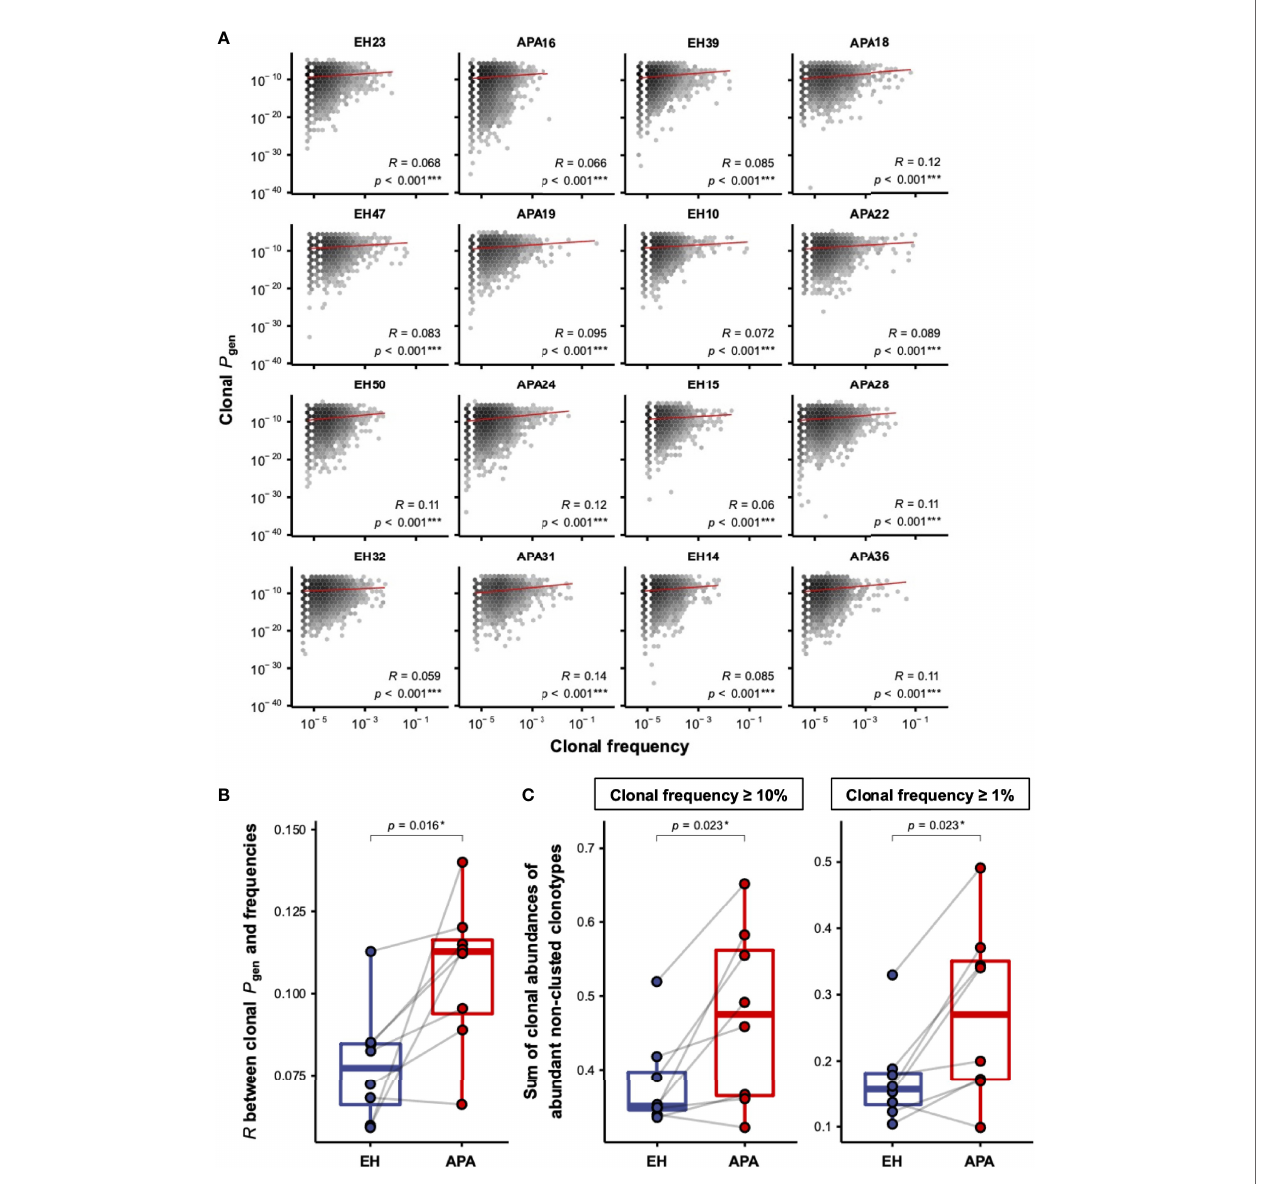
FIGURE 3 | Thecorrelationbetweenfrequencies and P gen ofTCR b clonotypes inAPAandEHpatients. (A) Thedistributionoffrequenciesand P gen ofTCR b clonotypeswas illustratedbythehexagonalheatmapforeachpatient. Thecolordepthrepresentedthenumber of TCR b clonotypes with the corresponding clonal frequency and P gen . Thecorrelationbetweenlog10-transformedfrequencies and P gen ofallclonotypeswascomputedusinglinear regressionanalysis.Thesolidredlinerepresentedthe fi ttedlinear regressionlinefor theobserveddata.Thecorrelationcoef fi cient ( R )and p -value ( p ) oftheassociationbetweenclonalfrequencies and P gen werelabeledfor eachpatient. Thetwo- sided p -values wereshownfrom thePearsoncorrelationtest. (B) Pearsoncorrelationcoef fi cients( R )betweenlog10-transformedfrequencies and P gen ofTCR b clonotypes were comparedbetweenAPAandage-matchedEHpatients. Thesolidgraylinedenotedage-matchedpairs. Thetwo-sided p -valueswereshownfrom the Wilcoxonsigned-ranktest. (C) ThecomparisonofcumulativefrequenciesofabundantTCR b clonotypes,de fi nedas clonotypeswithfrequencieslarger thanor equalto thefrequencyofclonotyperankedat thetop10% (leftpanel) or 1% (rightpanel)ofeachpatient,betweenAPAandage-matchedEH patients.Thesolidgraylinedenotedage-matchedpairs.Thetwo-sided p -values wereshownfrom theWilcoxonsigned-ranktest. p -values <0.05 or <0.001wereconsideredtobestatisticallysigni fi cantandmarkedwith ‘ * ’ or ‘ *** ’ ,